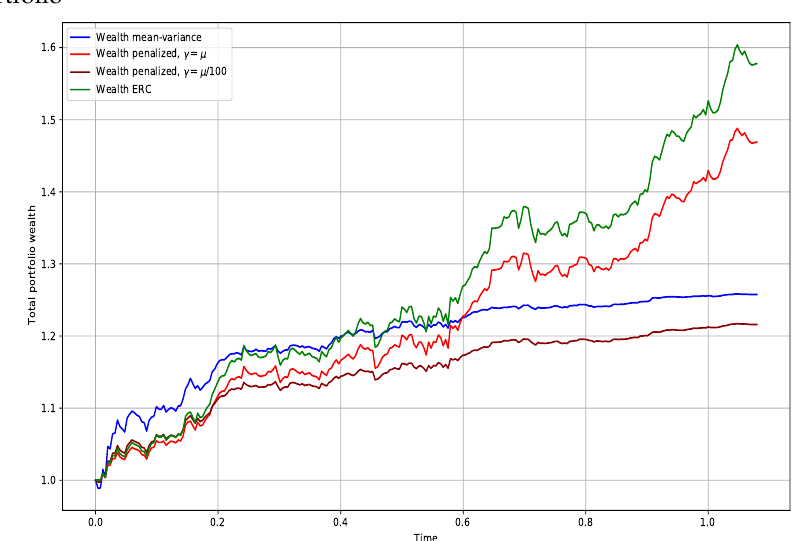
Figure 7. Sharpe ratios: Mean-variance: 0.183; ERC: 0.258; Penalized γ = µ : 0.260; Penalized γ = µ /100: 0.225.